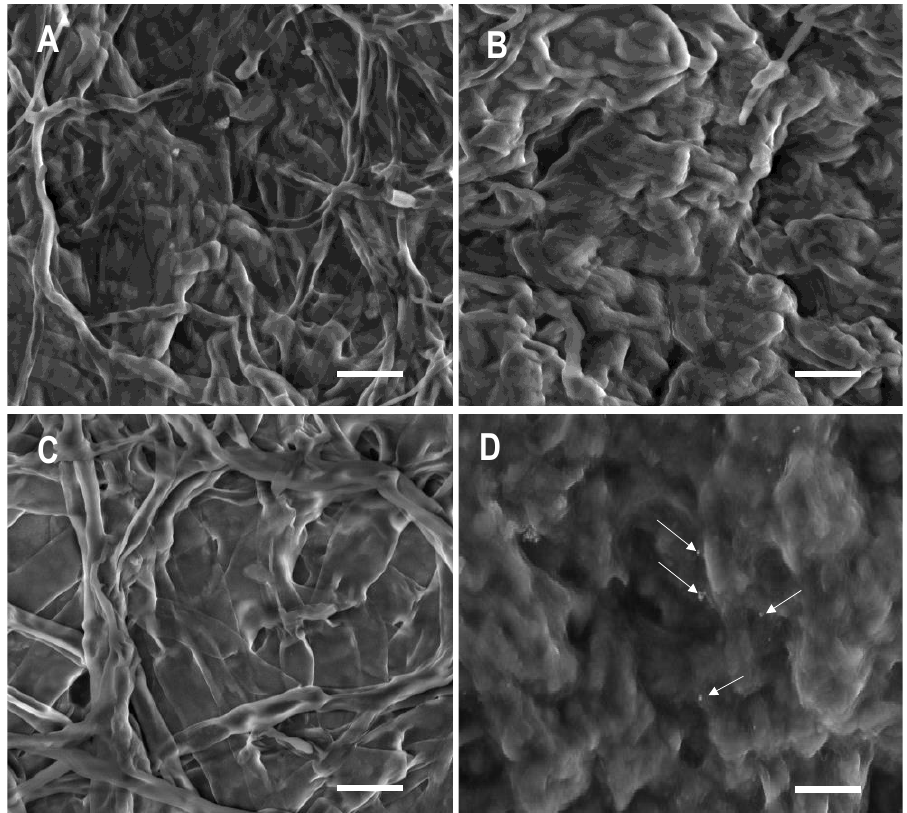
Figure 4. Scanning electron micrographs of C. gloeosp mycelium ( A ) No treatment (control), ( B – D ) Cu-NP, CuO, and CuO-NP treatments, respectively, at 500 mg/mL. In (D), arrows point to small NPs present on the surface of the pathogen’s vegetative part. Pictures were obtained using a FEI Quanta 400 (Thermo Fisher Scientific, Japan) operating in low vacuum with water vapor and an accelerating voltage of 10 kV at 4000x magnification. Scale bar = 40 μ m.